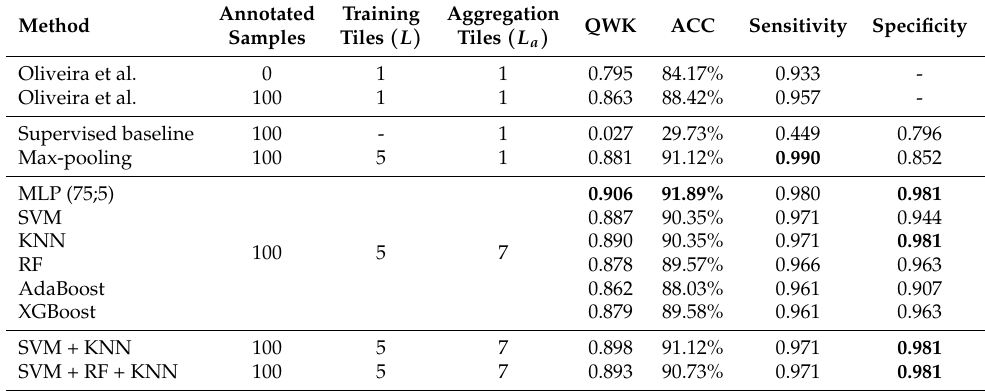
Table 2. Comparison of feature aggregation methods against the approach of Oliveira et al. [17], on the same test set. Both the ACC and the QWK score were computed for a three-classes problem, whereas the sensitivity and the specificity were computed for a binary problem by considering the LG and HG classes as an unique class. In bold are the best results per column.